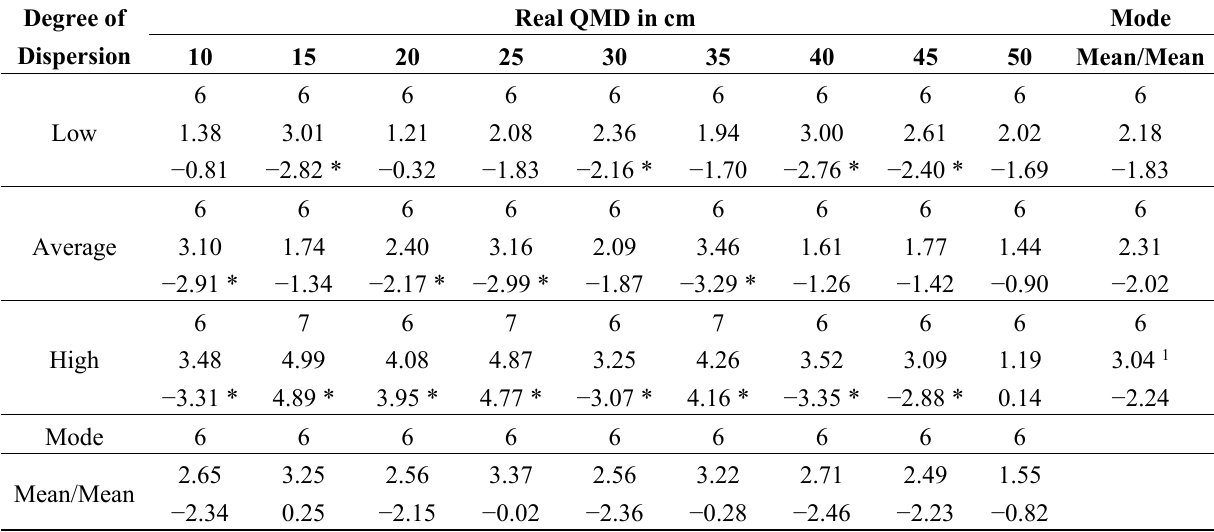
Table 6. The optimal rank, accuracy, and bias of QMD estimation for the best one-measurement variants of Weise’s rule (the values in column for each combination of QMD and DoD are optimal rank followed by RMSE and bias in